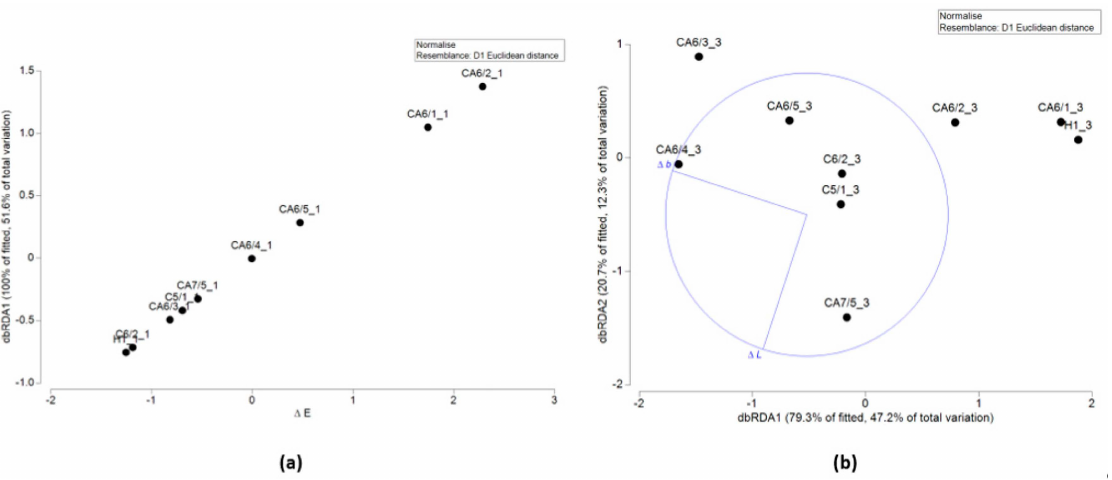
Figure 3. Multivariate analysis performed with Primer7 to determine possible correlation between particle contact area and color variations on ecotoxicological responses in salt water: ( a ) time 1 (i.e., 3 days); ( b ) time 3 (i.e., 180